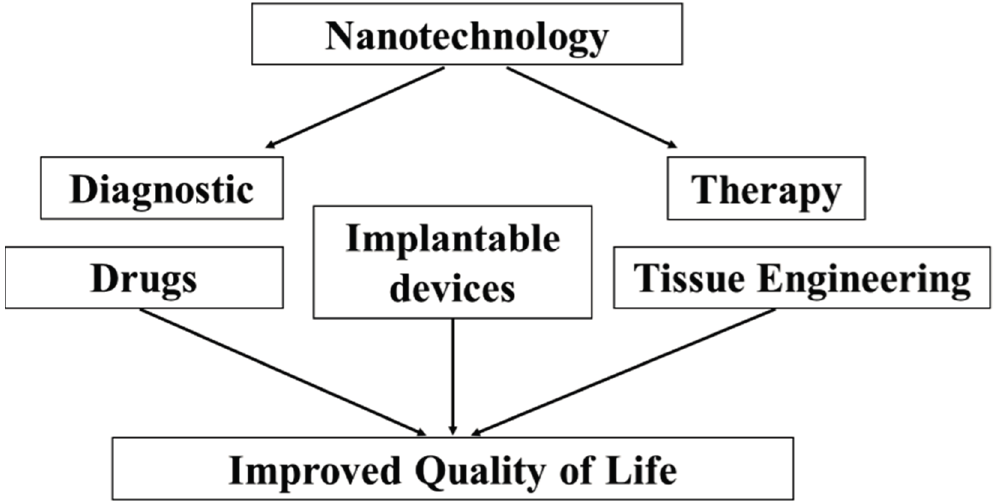
Figure 1. Patients benefit from advances in nanotechnology in medicine. To further